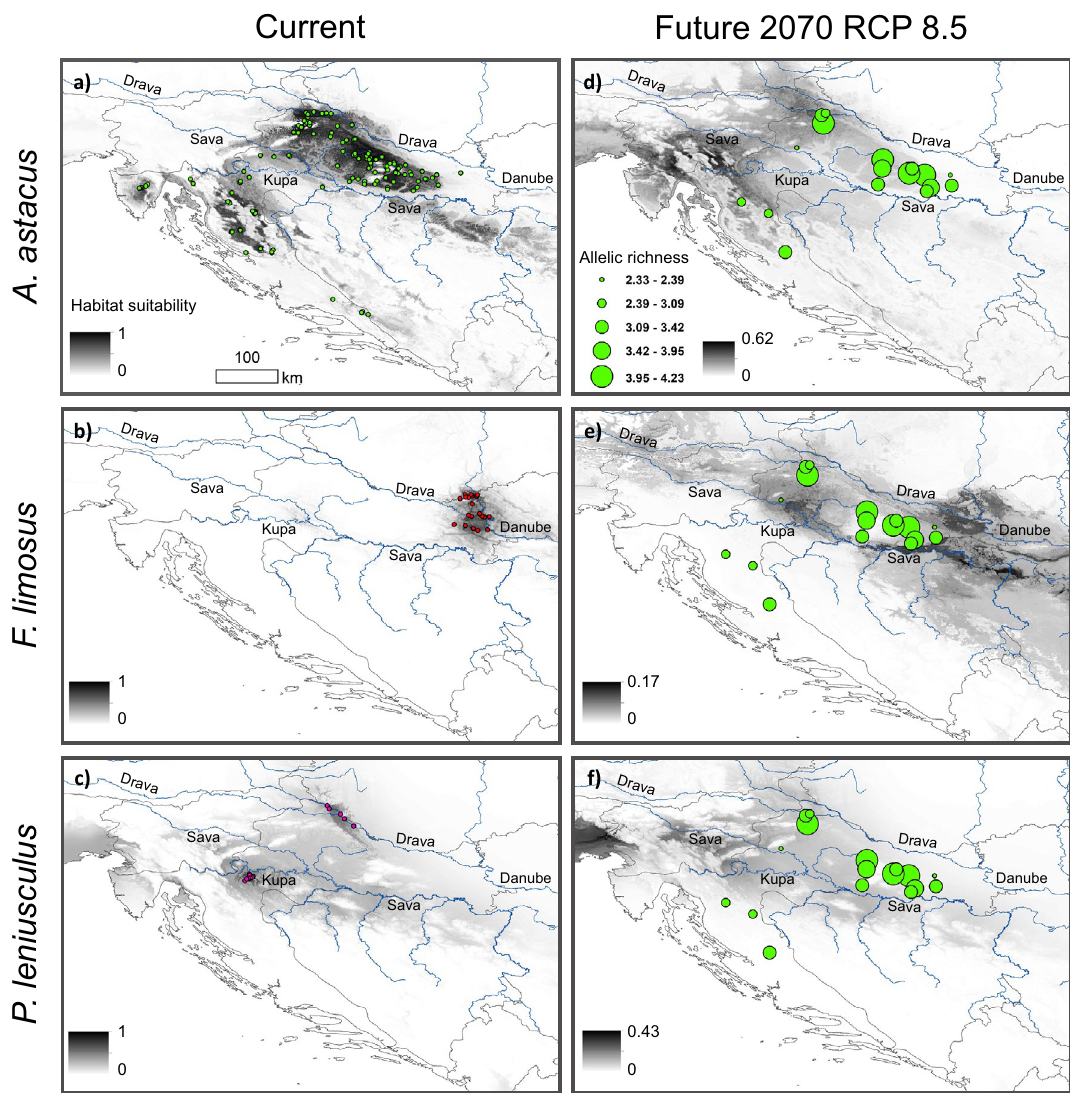
Figure 3. Ensemble potential habitat suitability for indigenous Astacus astacus and the two NICS, Pacifastacus leniusculus and Faxonius limosus in Croatia under current conditions (a–c) and future RCP 8.5 scenario in 2070 (d–f) based on SDMs. Occurrences of each species used for building SDMs are shown with coloured points (a–c) . Note that habitat suitability values in current projections are on the scale from 0 (unsuitable) to 1 (high suitability), while in the future projections habitat suitability values are on the scale from 0 (unsuitable) to maximum projected habitat suitability value. Future projections (d–f) of all species are shown in relation with the distribution of A. astacus allelic richness. Maps were produced in ArcGIS 10.3 program package by authors of this